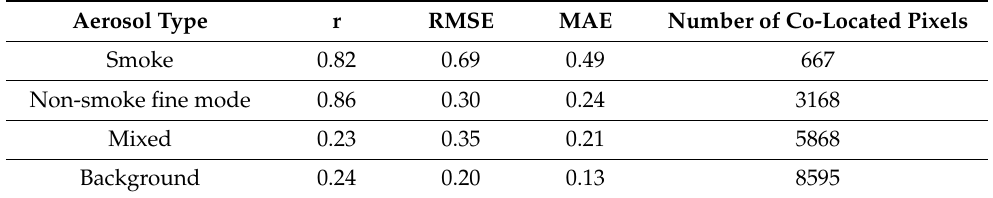
Figure 4. Scatterplot comparison of AOD at 550 nm derived from AEROS5P with respect to co-located retrievals from ( a ) MODIS/AQUA and ( b ) VIIRS for the period 20–24 December 2019. Colors in panel ( a ) represent the number of points for each sector of 0.1 × 0.1 of AOD. For ( a , b ), purple lines are linear regression lines of the scatter of points, dotted lines are the 1:1 curve and blue shade is the ± 20% interval. ( c ) Frequency histogram of differences of AOD at 550 nm of MODIS/AQUA and VIIRS with respect to AEROS5P. Symbols and colors in panel ( b ) indicate the aerosol type derived from the VIIRS approach. Table 2. Comparison of AOD from AEROS5P and VIIRS for each aerosol type detected by VIIRS. r: Pearson correlation coefficient; RMSE: Root Mean Squared Error; MAE: Mean Absolute